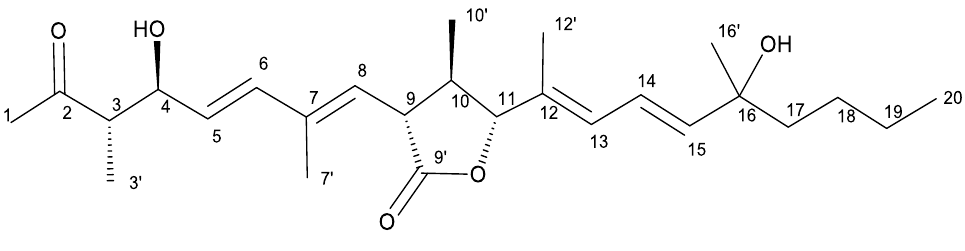
Figure 1. Structure of curvicollide D.